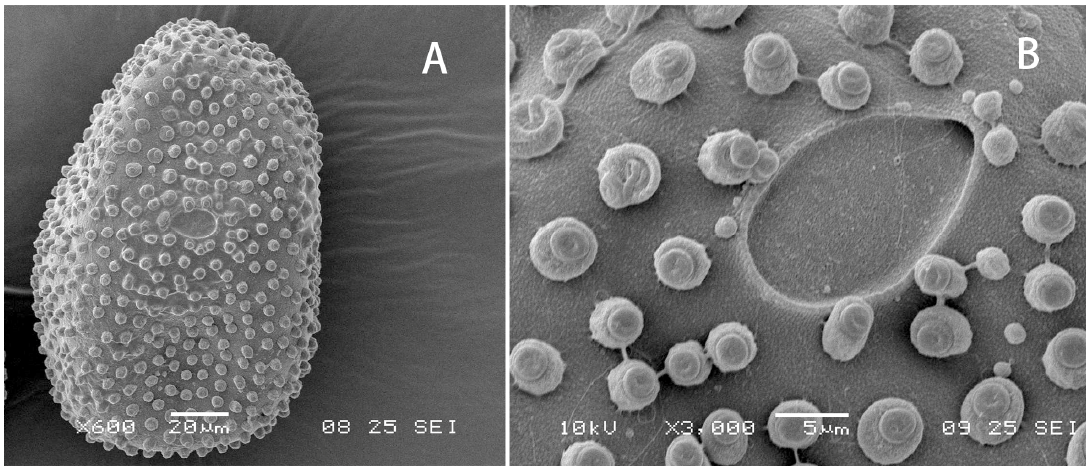
Figure 9. Egg of Regulaneuria cingulata : ( A ) Whole picture; ( B ) Micropyle and small KCTs enlarged.